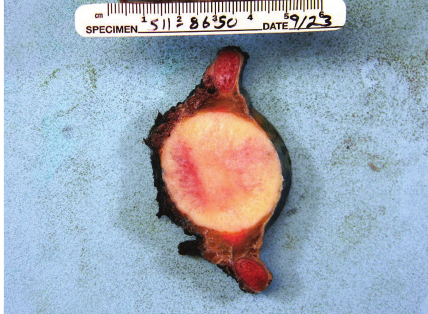
Figure 2: Gross examination of the mass showing a tan white hard mass involving the medullar cavity of the rib with extension to adjacent soft tissue.